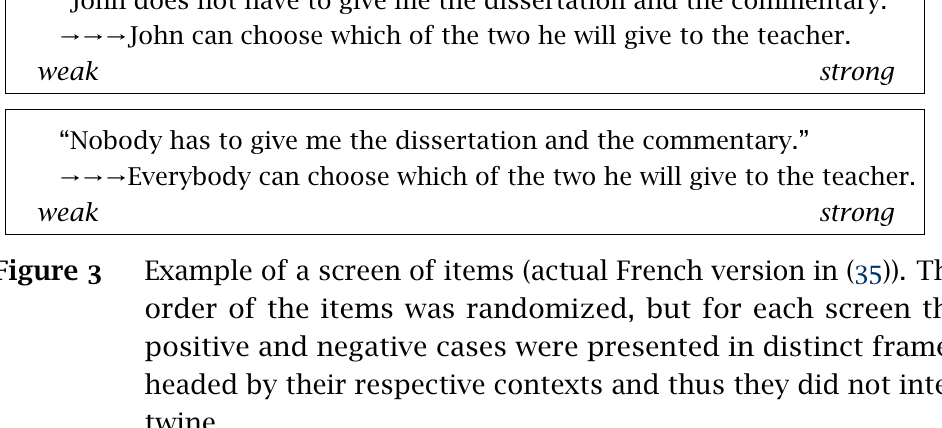
Figure 3 Example of a screen of items (actual French version in ( 35 )). The order of the items was randomized, but for each screen the positive and negative cases were presented in distinct frames headed by their respective contexts and thus they did not inter-